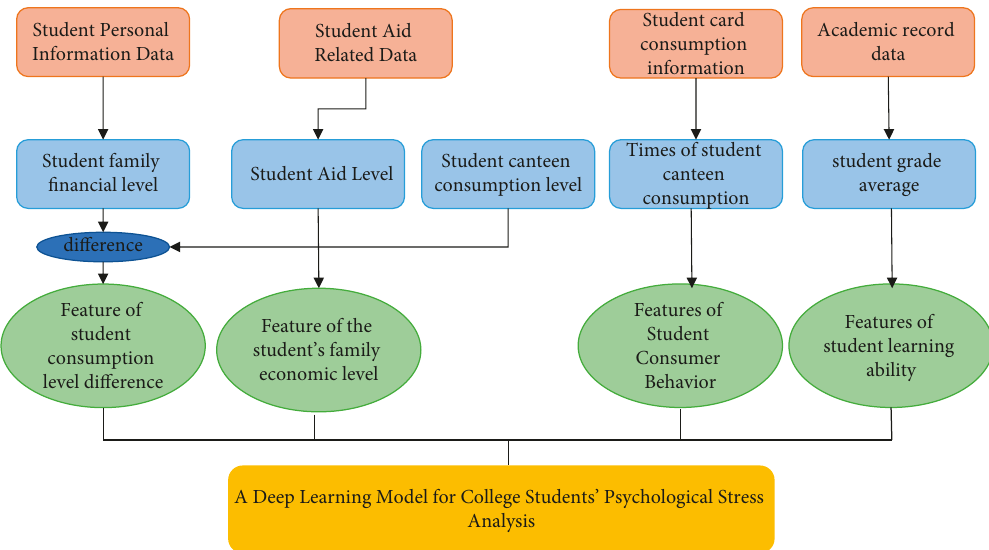
Figure 3: Analysis framework of college students’ psychological stress based on deep learning